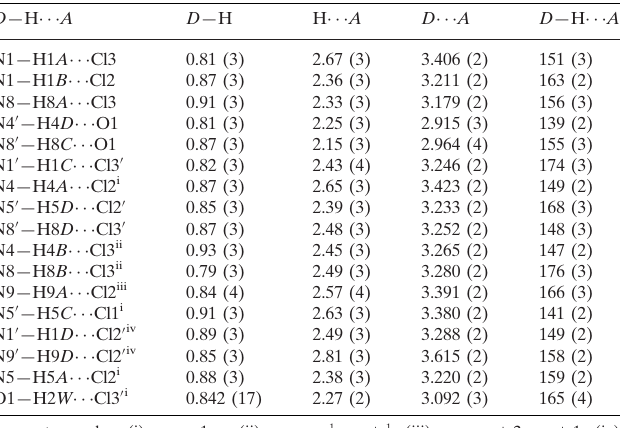
Hydrogen-bond geometry (A˚ , (cid:3)